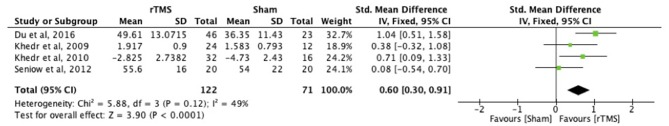
Effects of rTMS applied within 1 month with outcome assessment at 3 months post-stroke. Estimates of effect size are shown with 95% CIs. The standardized mean difference (SMD) and 95% confidence intervals (CIs); ICF Function measures: Fugl-Meyer Arm and Grip Strength.